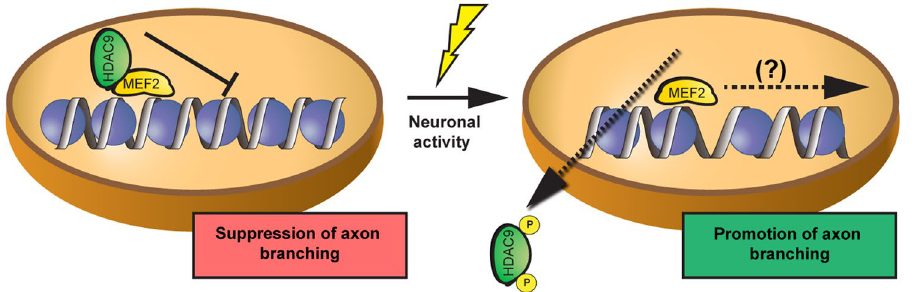
Figure 7. Working model of HDAC9 function in axon branch formation. HDAC9 is confined to the nucleus, where it can bind to transcription factors such as MEF2 and represses axon branching. Neuronal activity induces HDAC9 export to the cytoplasm, which promotes axon